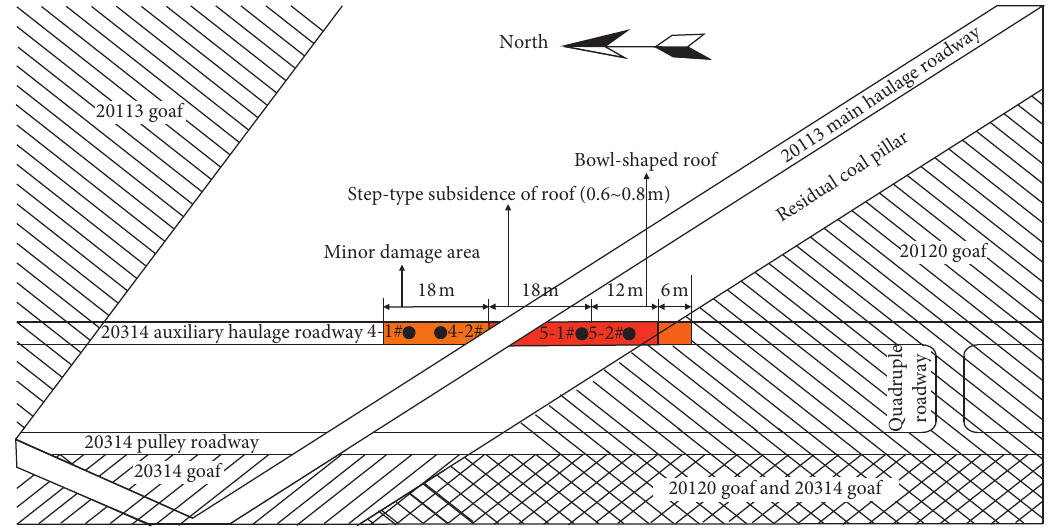
Figure 5: Deformation and failure range of the roadway.